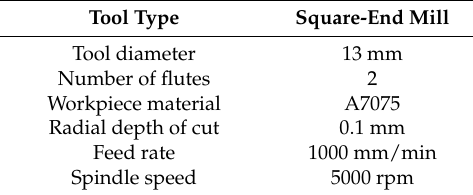
Table 1. Cutting condition.